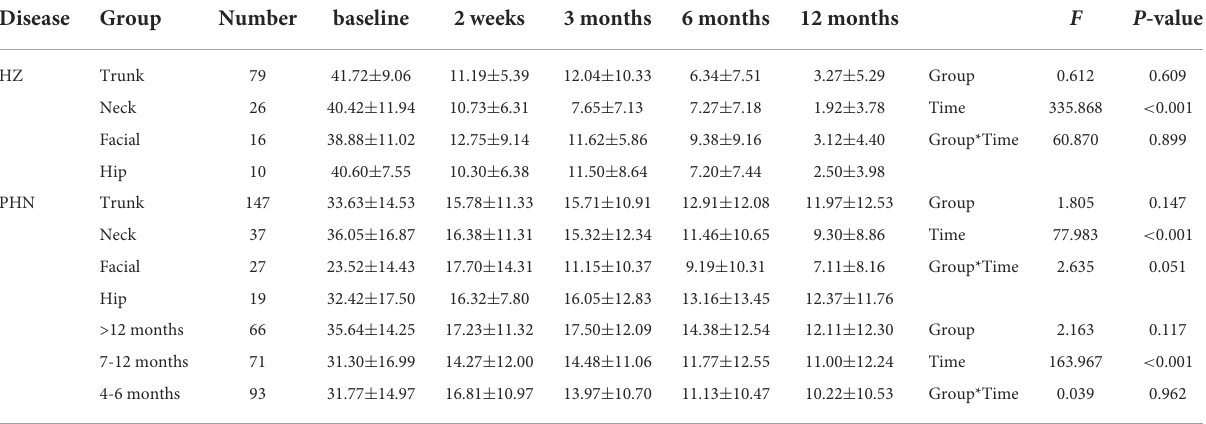
TABLE 5 Two-way repeated measures ANOVA for between group and time interactions of BPI scores in patients with HZ and PHN. Disease